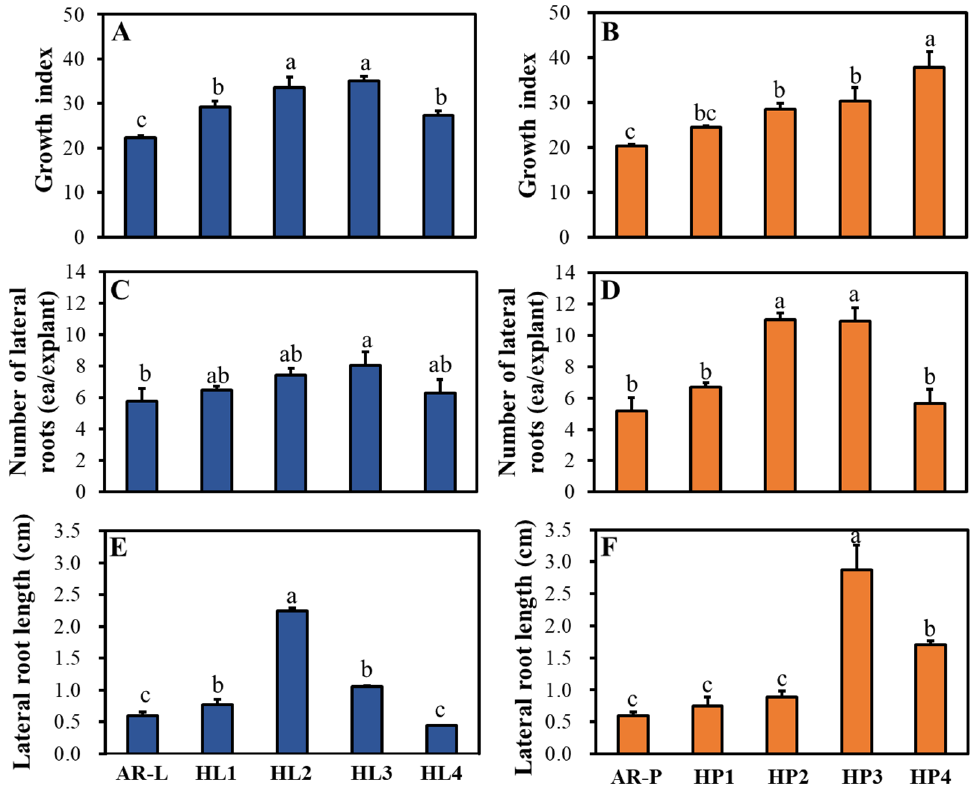
Figure 2. Growth characteristics of different HR lines after 3 weeks of culture. ( A , C , E ) Growth index ( A ), lateral root number ( C ), and lateral root length ( E ) of non-transgenic adventitious root (AR) and HR cultures induced from leaf. ( B , D , F ) Growth index ( B ), lateral root number ( D ), and lateral root length ( F ) of AR and HR cultures induced from petiole. AR-L and AR-P, leaf- and petiole-derived AR lines, respectively; HL and HP, leaf- and petiole-derived HR lines, respectively. Data represent mean ± standard error (SE). Different lowercase letters above bars indicate significant differences (Duncan’s multiple range test [DMRT]; p ≤ 0.05).